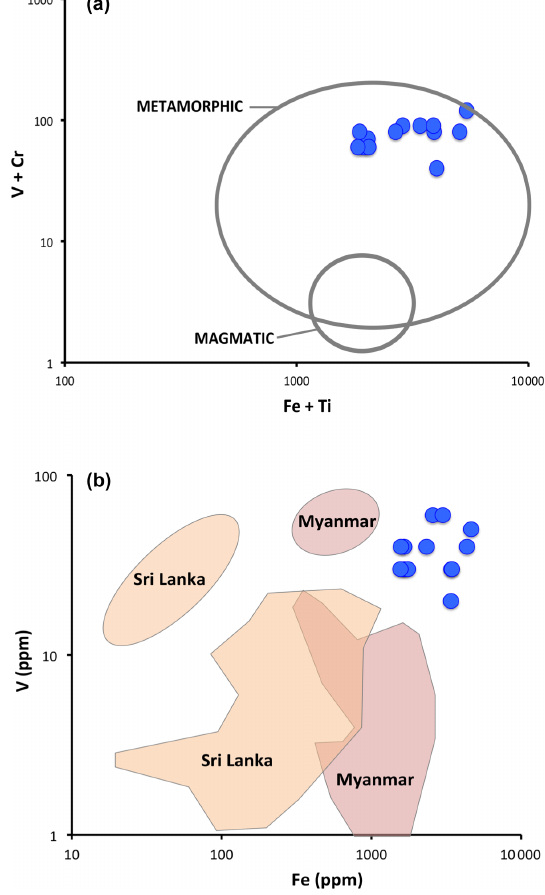
Figure 6. Chemical compositions of sapphire from the reliquary crown of Namur plotted in the (V + Cr) vs. (Fe + Ti) diagram estab- lished by Sutherland et al. (2015) and Chulapakorn et al. (2014) (a) , as well as in the Fe vs. V diagram published by Atikarnsakul et al. (2018) (b)